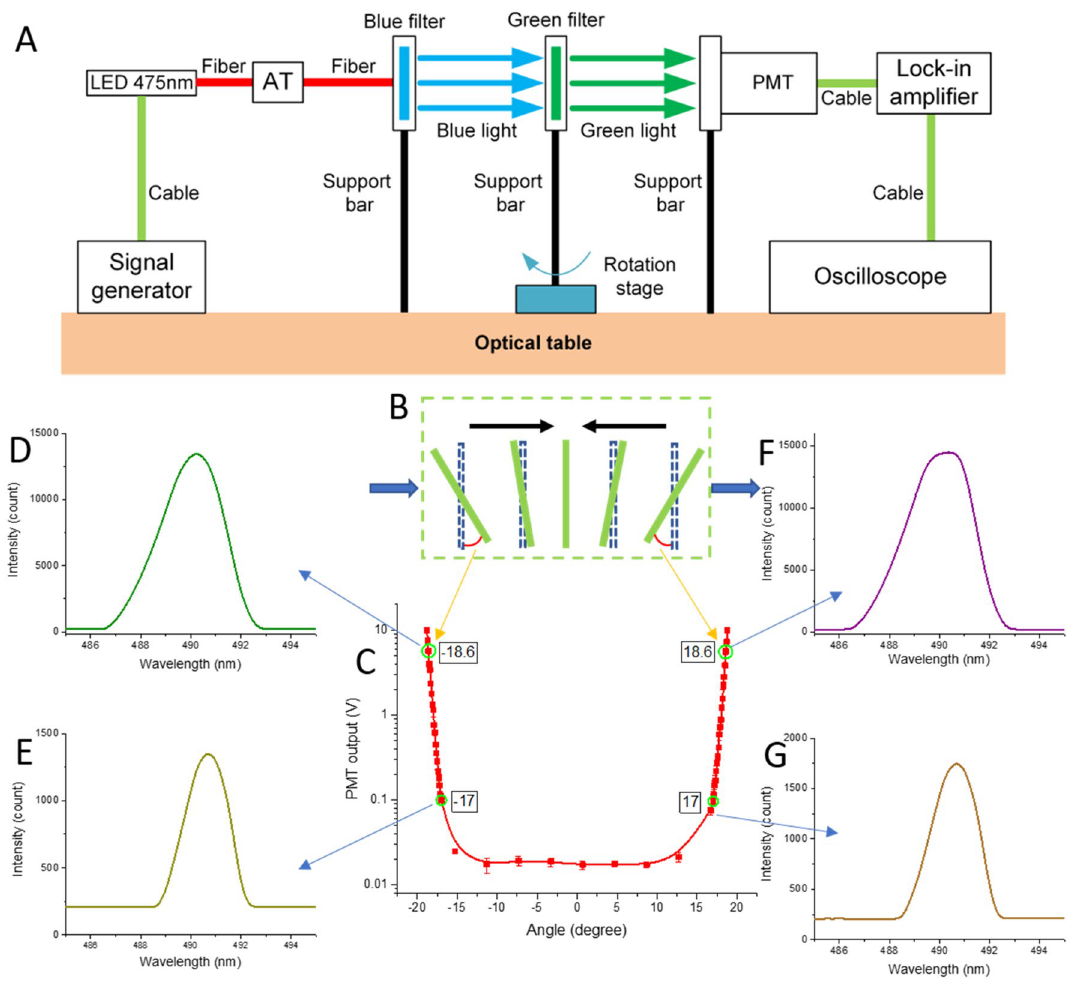
Figure 2. ( A ) Diagram of the light measurement through the rotated filter showing LED with a principal wavelength of 475 nm (LED 475 nm) connected to the excitation filter (blue) perpendicular to the light via optical fiber and attenuator (AT), emission filter (green) on a rotating platform, and either a photomultiplier tube (PMT) as light detector (shown here) or spectrum analyzer (not shown here). ( B ) Schematically showing the green filter rotation and its influence on ( C ) measured detected power on the PMT and ( D – F ) detected spectra for four different angles of the emission filter